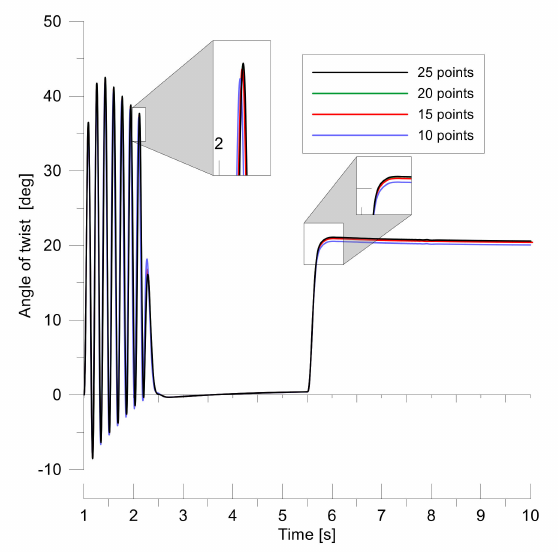
Figure 6. Angle of twist vs.